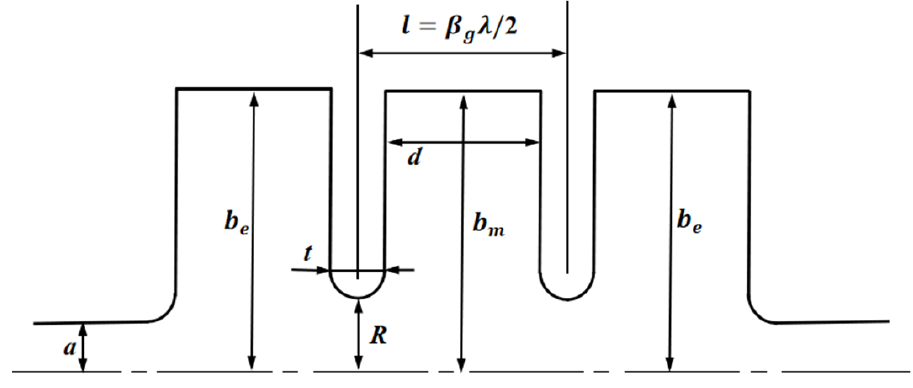
Figure 1. The two-dimensional drawing of the 3-cell deflecting cavity.